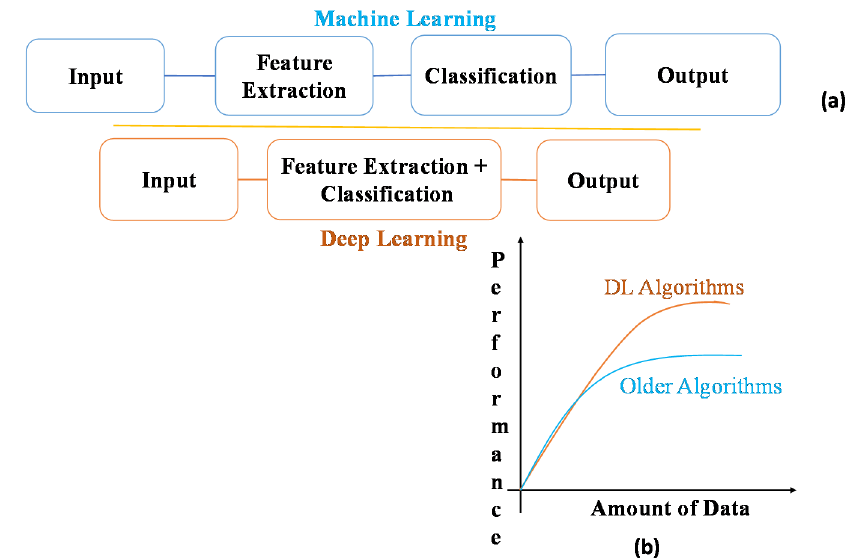
Figure 2. ( a ) Working process of machine learning and deep learning algorithms, and ( b ) the respective performance with the quantity of data provided [27].